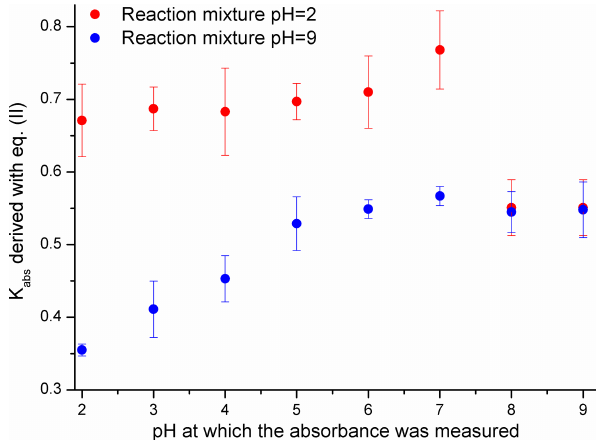
Figure 4. The ability of 4NP to generate products with an ab- sorbance between 250 and 600nm evaluated with K abs factors de- rived using Eq. (2). Uncertainties are precisions from the regression